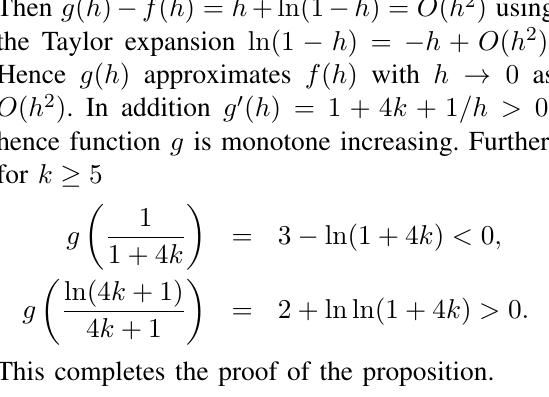
Fig. 1. The cut and logistic functions for γ = δ = 1 , k = 1 / 2